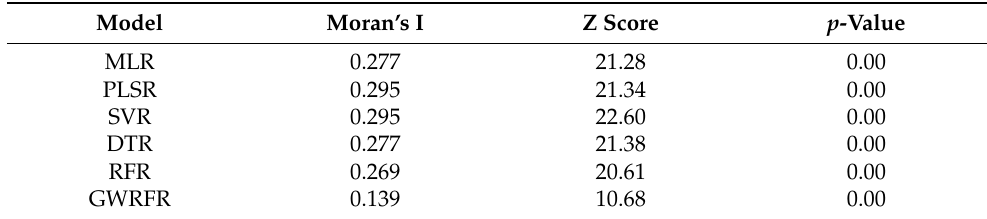
Table 3. Moran’s I value of residuals for MLR, PLSR, SVR, DTR, RFR, and GWRFR.